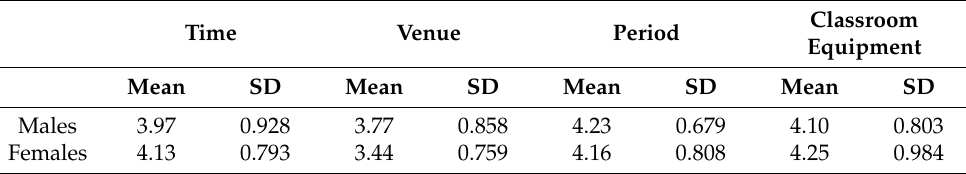
Table 8. Mean values and standard deviations of “spatial technical/logistical infrastructure” ques- tions in relation to gender of budding